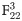
Multi-step perturbation experiment.The SPSD of the Boolean function F223 is depicted. The single-line blue and double-line green nodes and edges are related to the first and the second step of the perturbation, respectively. Starting from the initial state number 3, we can perform the O1, D2, and D3 perturbations and switch to the state numbers 7, 1, and 2, respectively. Assume that we start the second step of the perturbation from the state number 2 and perturb by O1, D2, and O3. The two-step perturbation experiment performs as the multi-perturbation experiment perturbing two regulators simultaneously starting from the first initial state; i.e., the simultaneous perturbation pairs (D3,O1), (D3,D2), and (D3,O3) starting from s = 3 are equivalent to the two-step perturbation experiment starting from the s = 3 and 2, as the first and the second initial states, respectively.